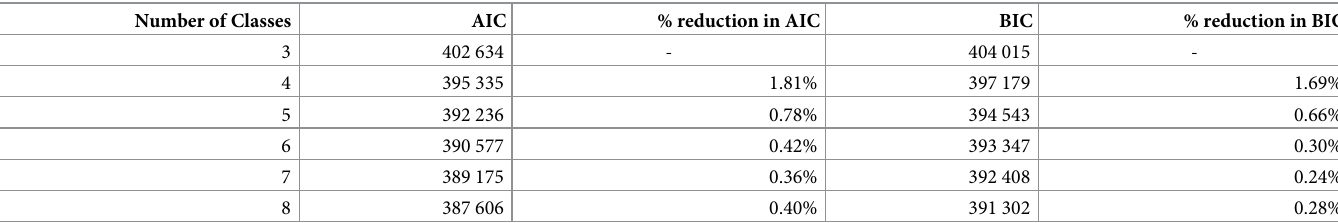
Table 1. Latent Class Model Development